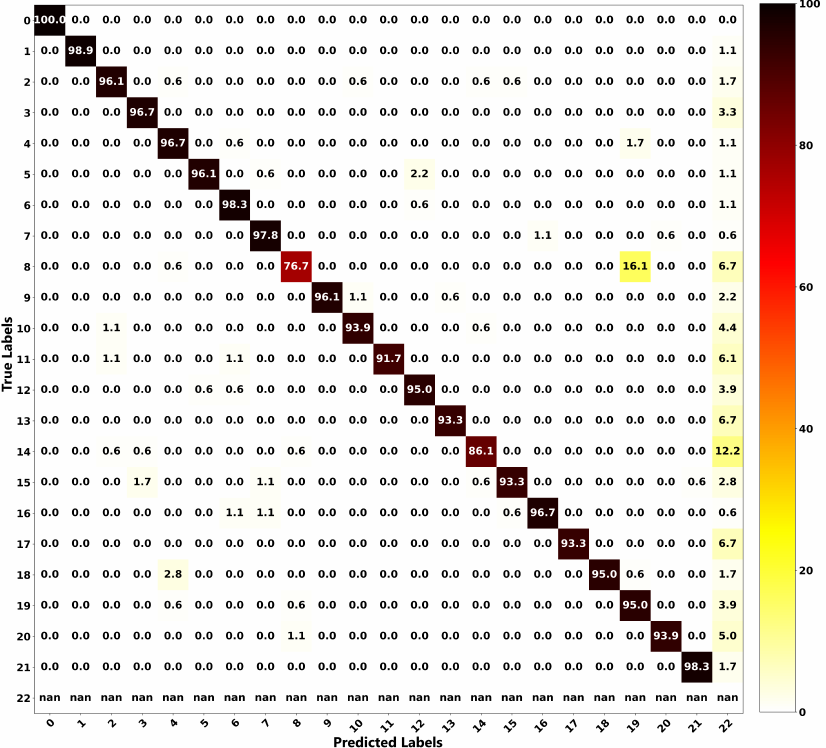
Figure 16. Confusion matrix for localization based on the proposed ANN, evaluated on test dataset.